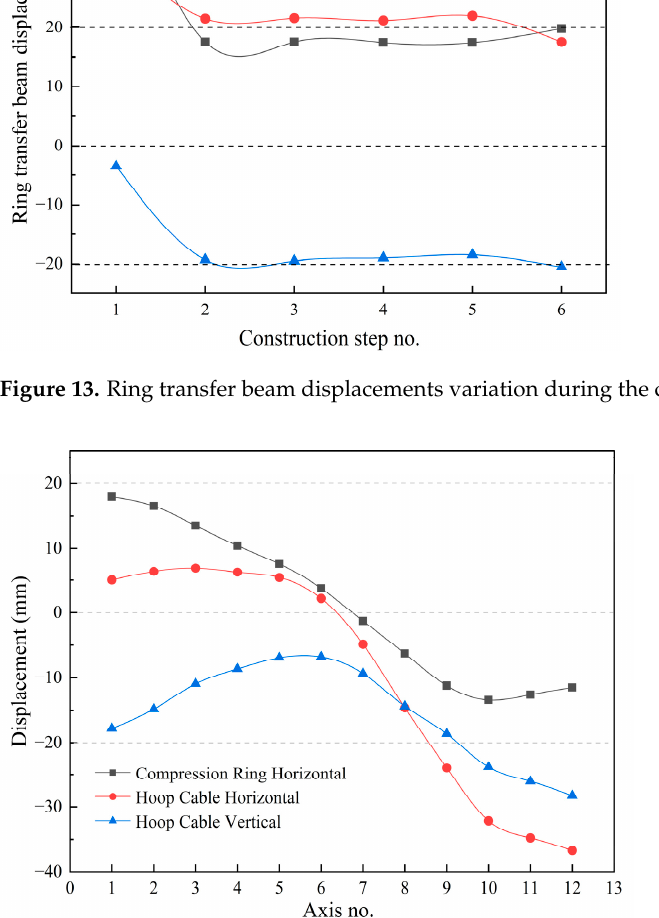
Figure 14. Displacement variation of compression ring and hoop cable during the construction pro- cess.